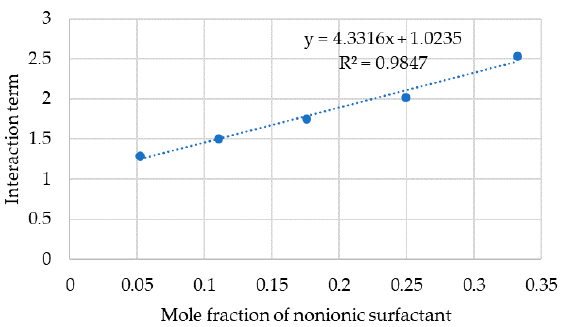
Figure 7. The interaction terms of SDHS-AAE(6EO4PO) systems. Figure 8. The average interaction terms of each anionic–nonionic ratio of SDHS-AAE(6EO4PO) systems.